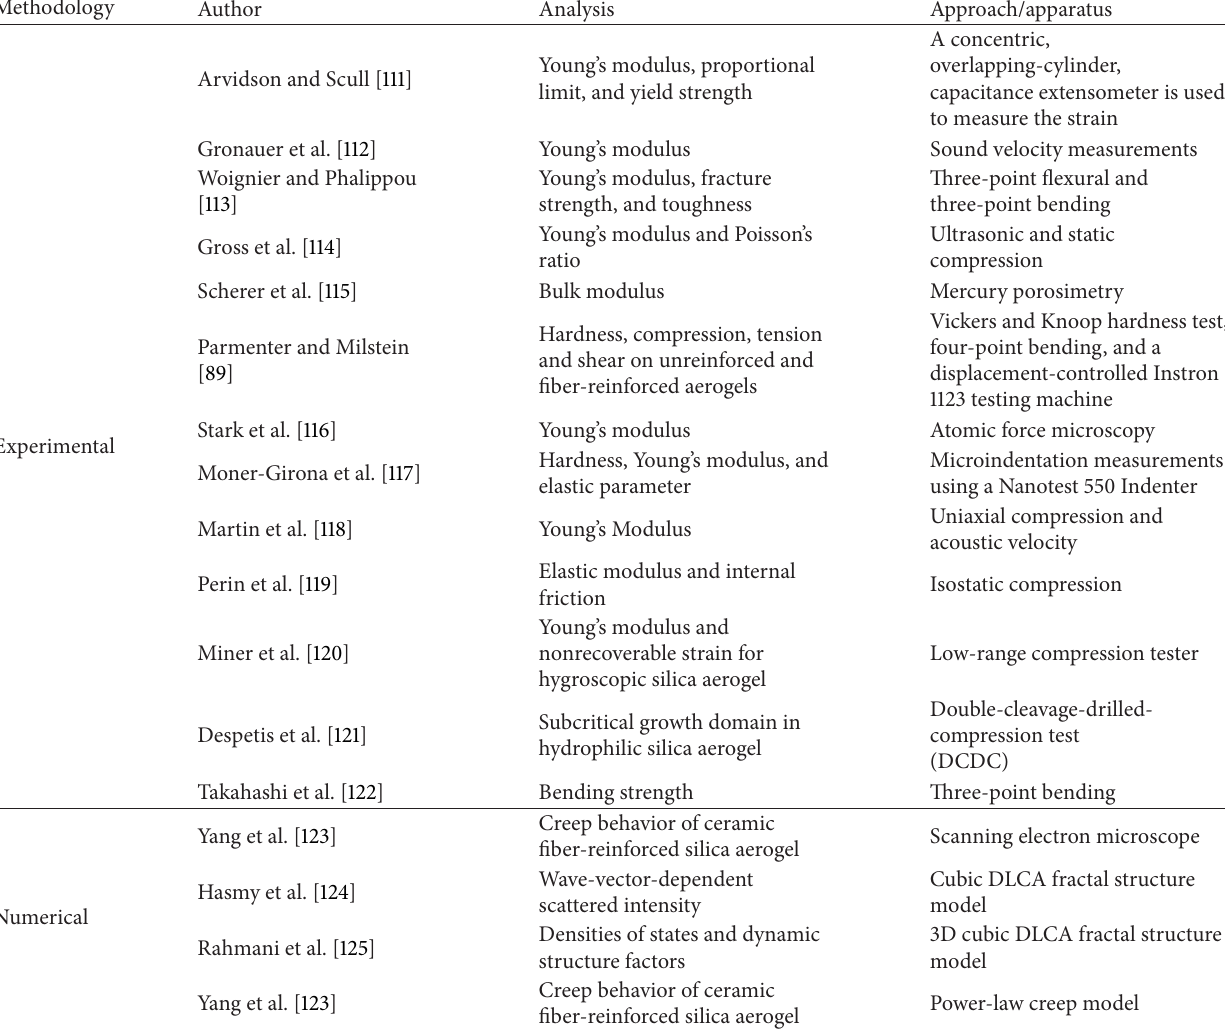
Table 3: Mechanical studies on silica